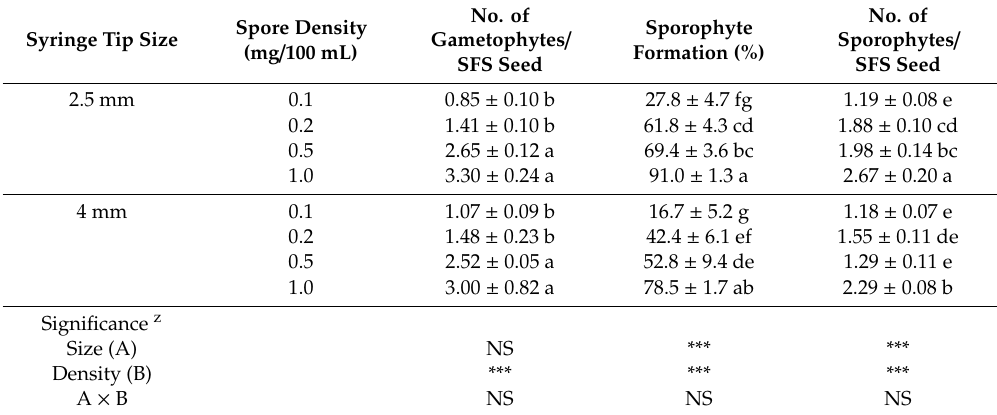
Table 1. E ff ect of syringe tip size and spore density on gametophyte and sporophyte formation from bracken SFS (synthetic seeds using fern spores).